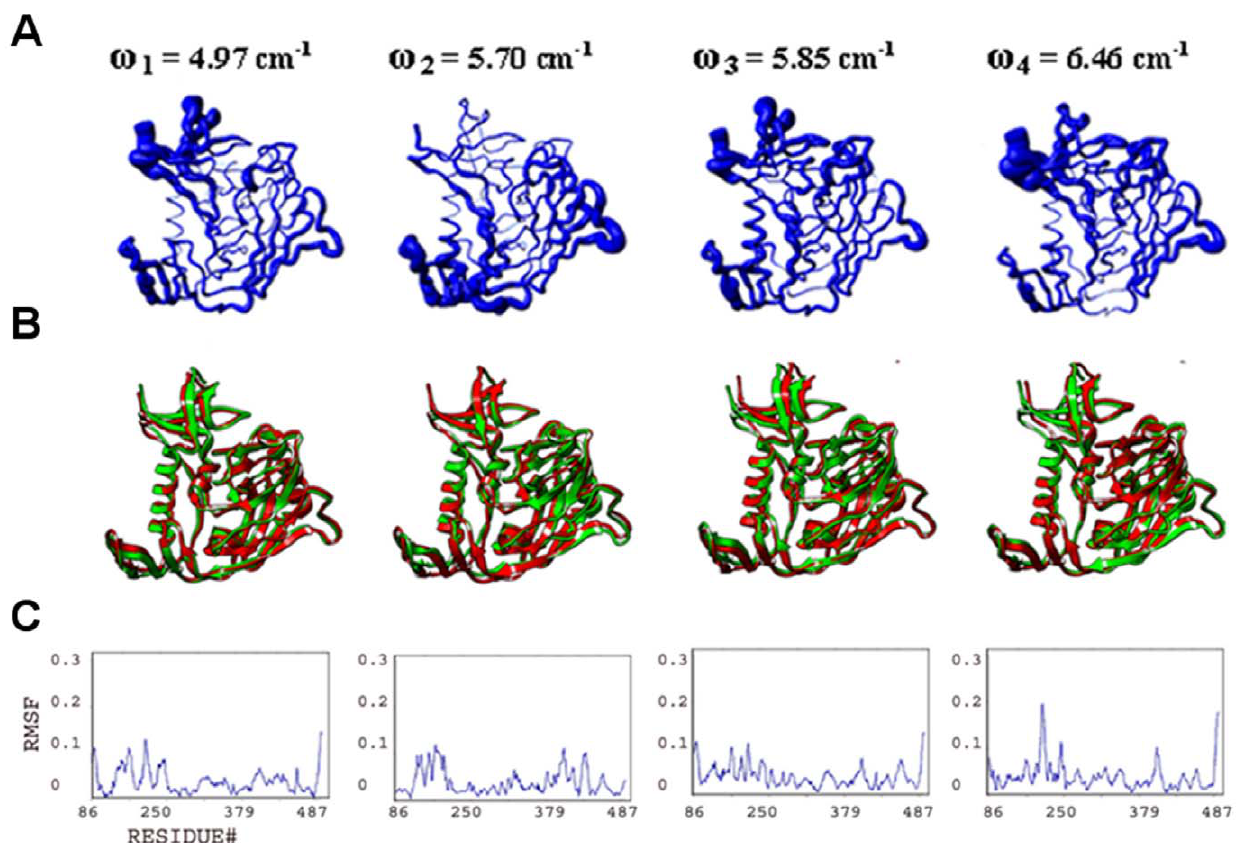
Figure 4. Conformational plasticity of gp120:D1. Features from the four slowest modes analyzed and displayed as in Figure 3, but for gp120 in its complex with CD4 D1. ( A ) Fluctuations mapped onto worm diagrams. ( B ) Superposition of conformers generated at extremes of the fluctuations. ( C ) Alpha-carbon RMSF plots.